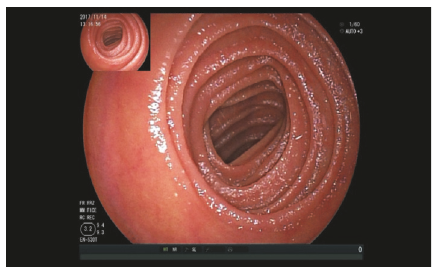
Figure 7: Enteroscopy showing normal jejunal mucosa.